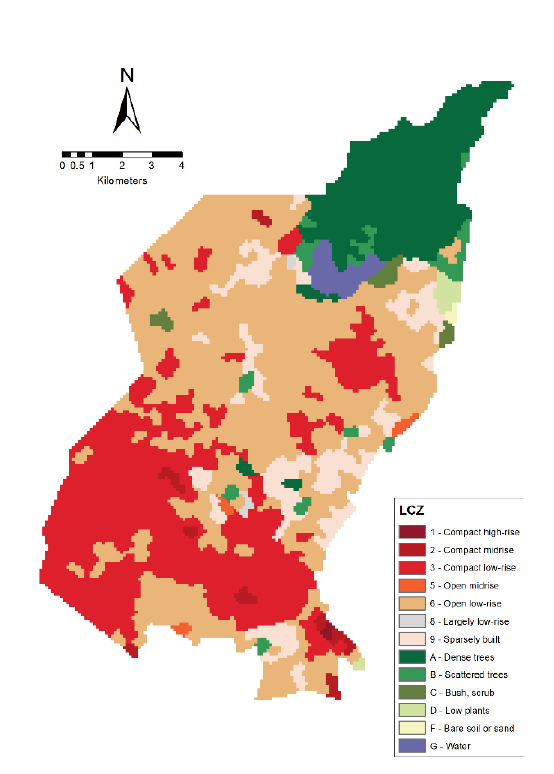
Figure 8. Local Climate Zone map of Quezon City, Philippines